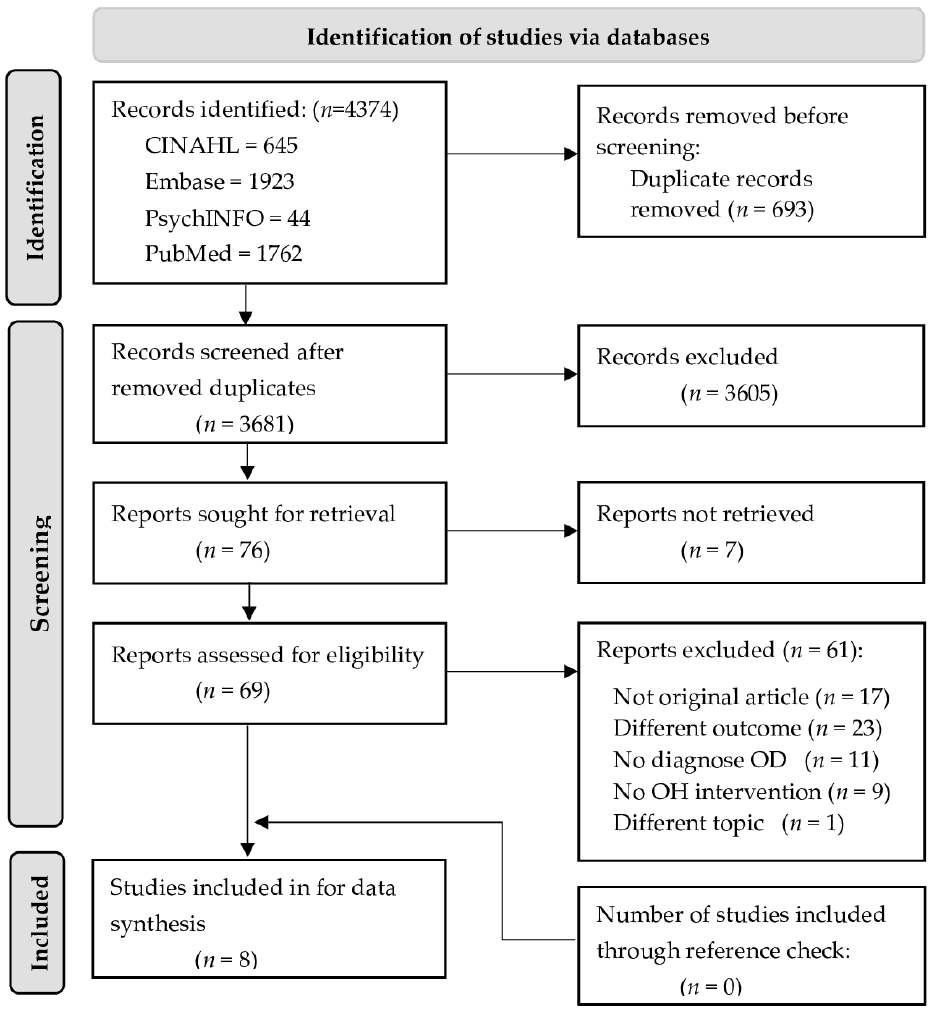
Figure 1. Flow diagram of the review process according to the Preferred Reporting Items for Sys- tematic Reviews and Meta-Analyses (PRISMA) [32]. Legend: OD = oropharyngeal dysphagia; OH = oral health.